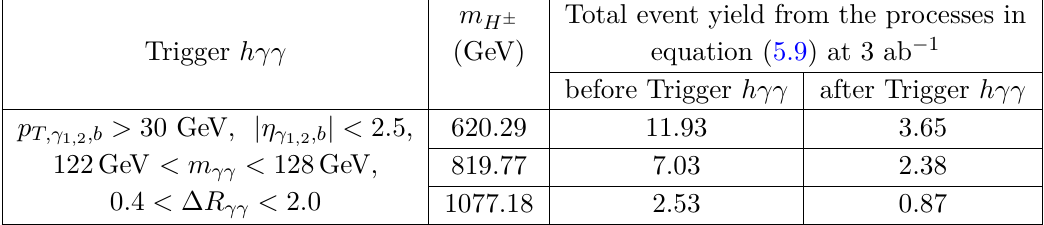
χ ± : p > 100 GeV and e 1 T, e χ ± 1 0 . 04